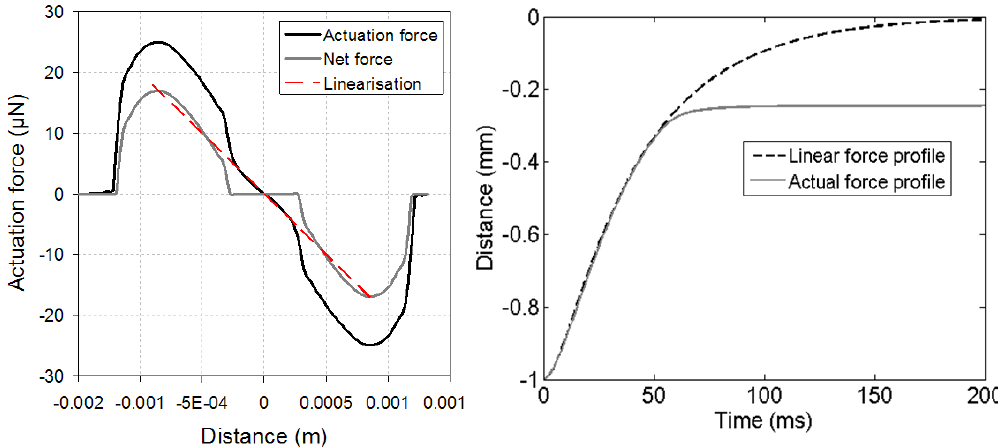
Figure 4. Force profile as a function of the droplet position for an actuation voltage of 45 V: actual calculated profile (solid black line), difference between the actuation force and the static contact line friction (solid grey line) and the linearized force profile (dashed line).